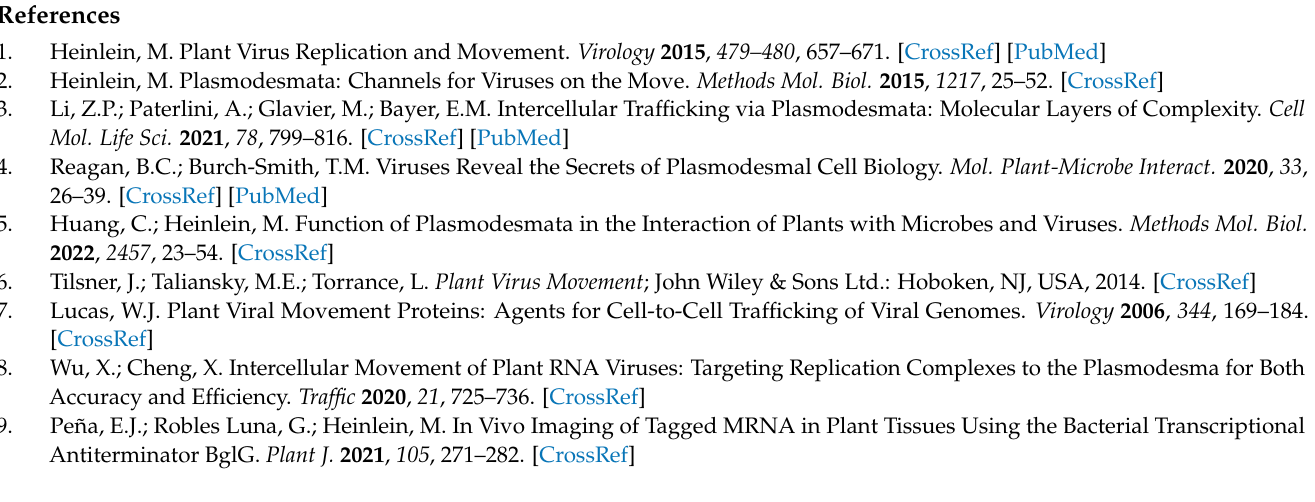
FRET-FLIM; Figure S3: Subcellular localization of GFP+22; Figure S4: Complementation of PVX-POL- GFP cell-to-cell transport. Figure S5: Amino acid sequence alignment of BMB2 proteins; Figure S6: Complementation of cell-to-cell movement of PVX-POL-GFP by BMB1-BMB2 and BMB1-BMB2 combination with BMB1. Table S1: Primers used in this study; Table S2: Synthetic genes used in this